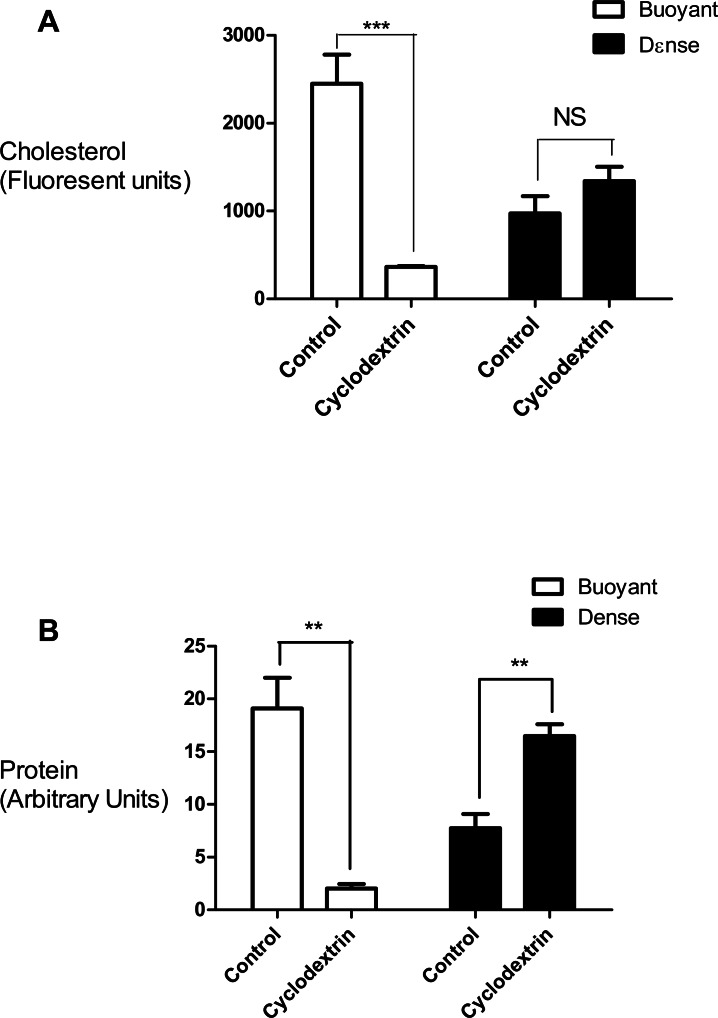
Effects of cyclodextrin on vesicle composition.Comparing the effects of cyclodextrin treatment on the biochemical composition of buoyant and dense membrane fractions isolated on equilibrium sucrose density gradients. (A) Change in cholesterol levels as determined by Amplex Red cholesterol assays. Note that there was no significant change in the total amount of cholesterol present in the dense membranes. (B) Levels of the membrane—associated protein PI4KIIα were determined by Western blotting and quantitated by image analysis software. Cyclodextrin addition causes a redistribution of PI4KIIα from the buoyant to the dense fractions. Results are presented as mean ± S.E.M from experiments repeated three times, ∗∗∗p < 0.001, ∗∗p < 0.01, NS not statistically significant using the two-tailed student t-test.